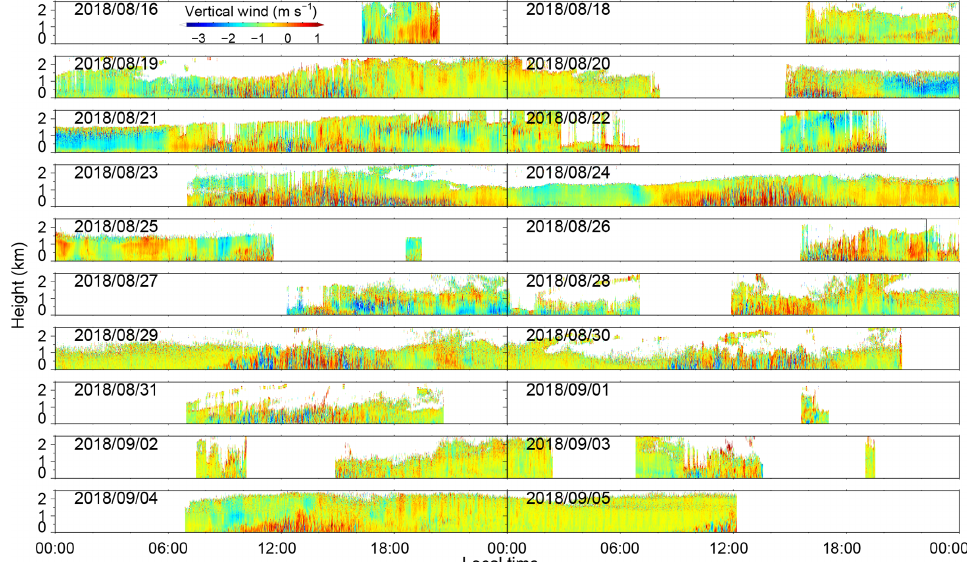
Figure A1. Time–height cross section of vertical wind speed per day during the experiment. Dates are shown in the top left of each panel, and are read as YYYY/MM/DD.